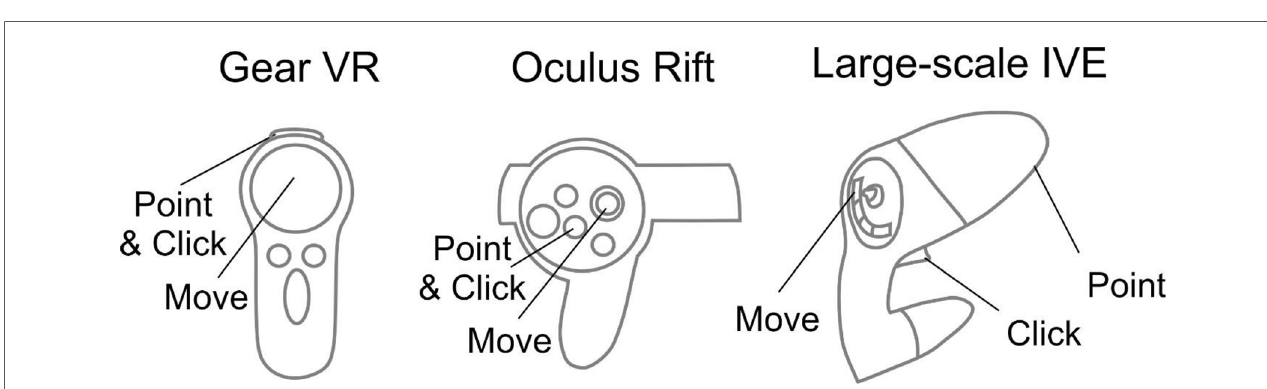
FIGURE 4 Controls implemented in the work fl ow. Controls for the Gear VR (left), Oculus Rift (middle), and large-scale immersive virtual environment via FlyStick 2 (right) are shown. The trackable controllers are viewed as an orange beam in the Unity Scene. The user positions the controller in space to point the beam at a portion of the results to be viewed and then make a selection via the buttons